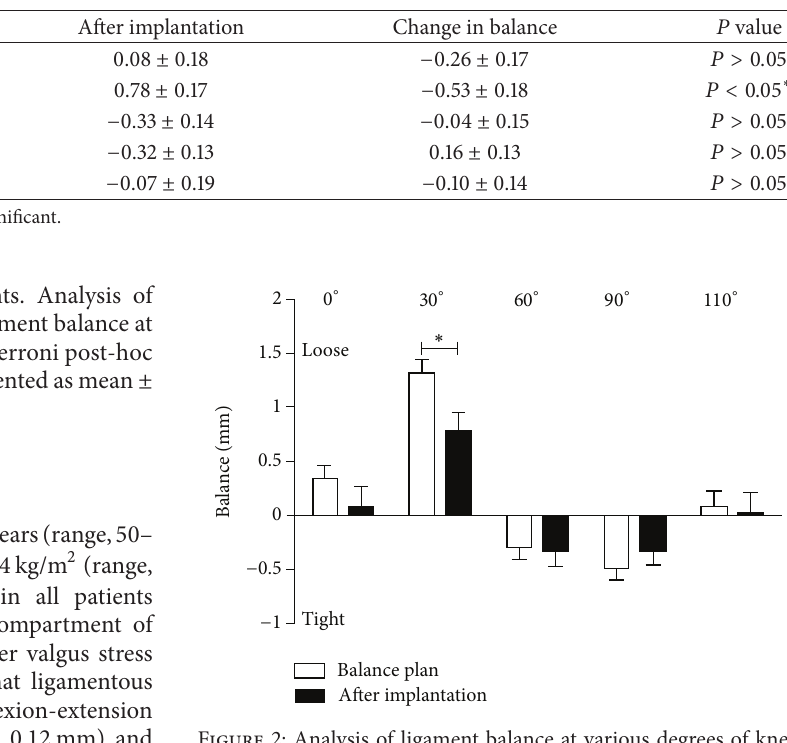
Figure 2: Analysis of ligament balance at various degrees of knee flexion. The intraoperative balance plan was similar measurements obtained after component implantation at 0 ∘ , 60 ∘ , 90 ∘ , and 110 ∘ . At 30 ∘ , ligament balance was relatively loose and surgically corrected, revealing a significant difference ( ∗ 𝑃 < 0.05 ) between the balance plan and measurements after component